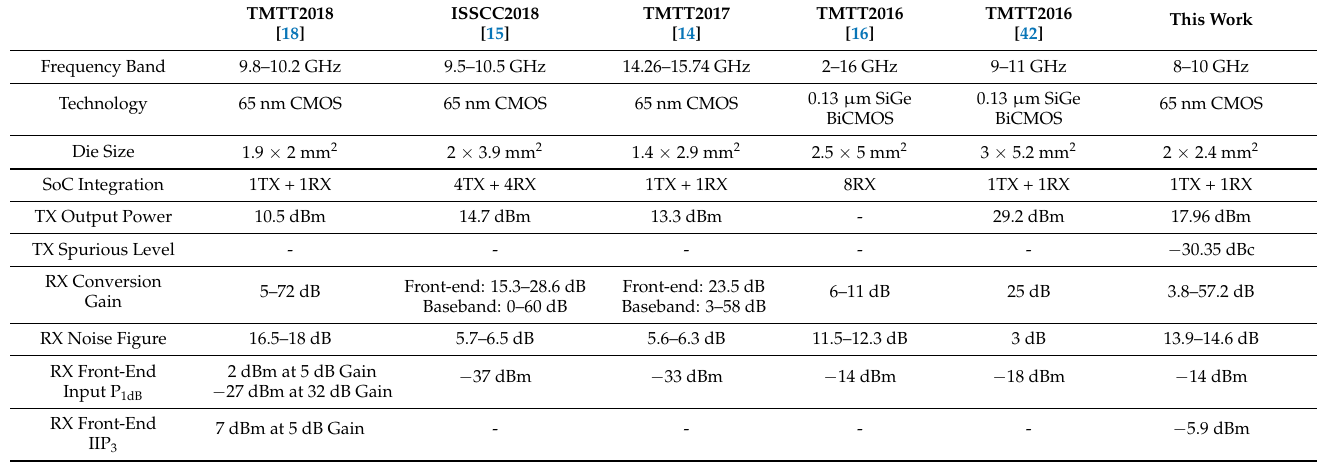
Figure 28. ( a ) Isometric view and ( b ) side view of the captured range–azimuth plot by using 16- element radar demonstrator. Table 1. Performance comparison with state-of-the-art fully customized radar